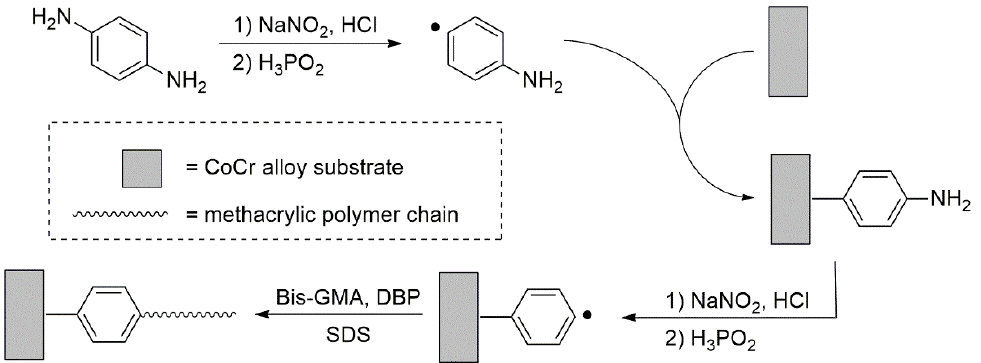
Figure 2. A route for surface treatment of metal with aryldiazonium